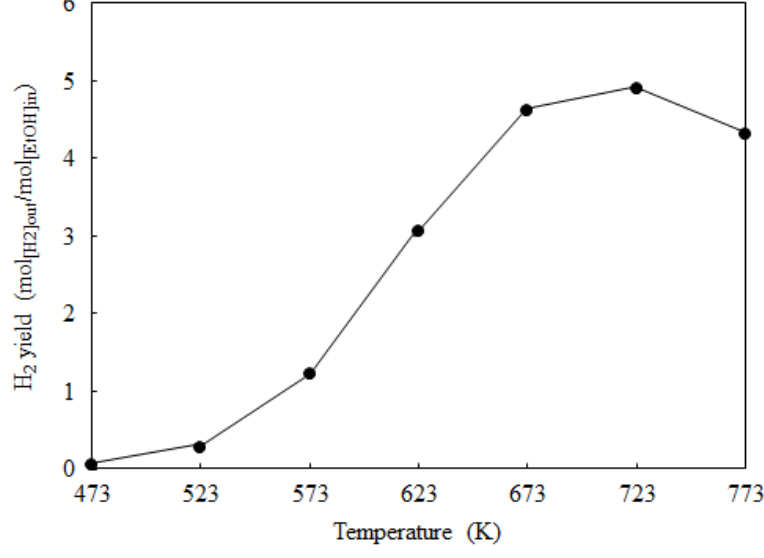
Figure 8. Effect of reaction temperature on H 2 yield over 7.7 wt. % Co/CeO 2 (hp).